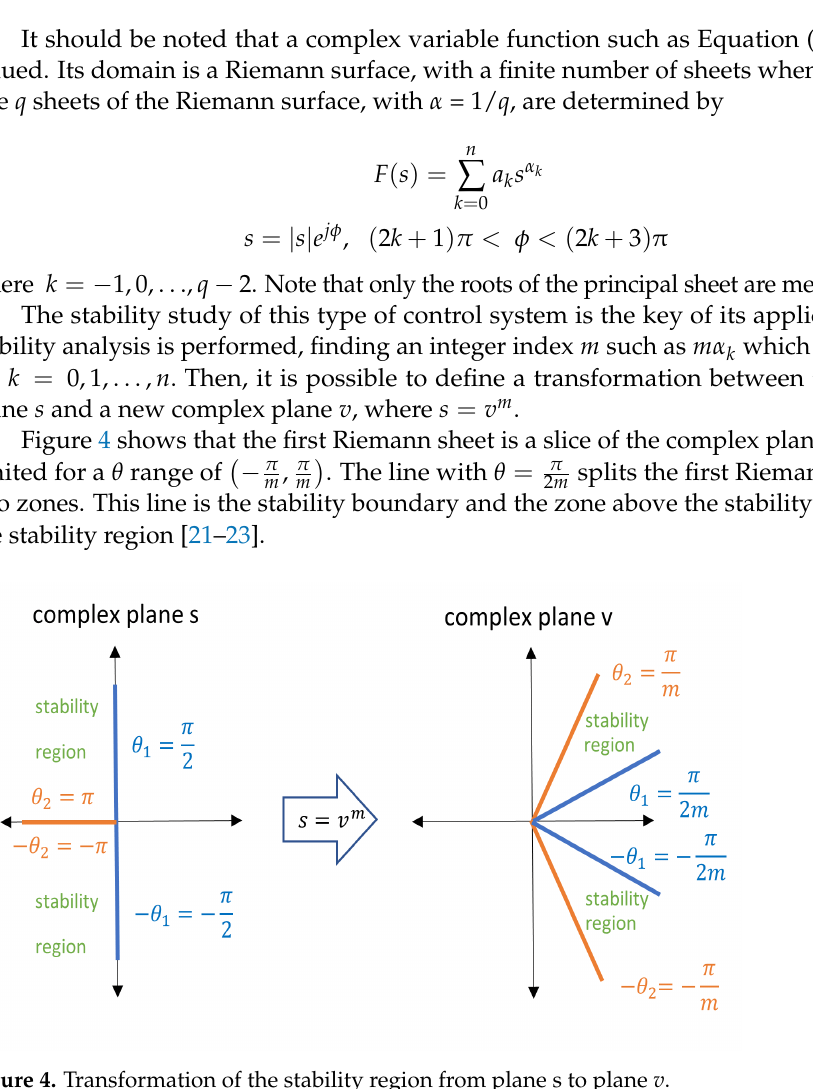
Figure 4. Transformation of the stability region from plane s to plane v